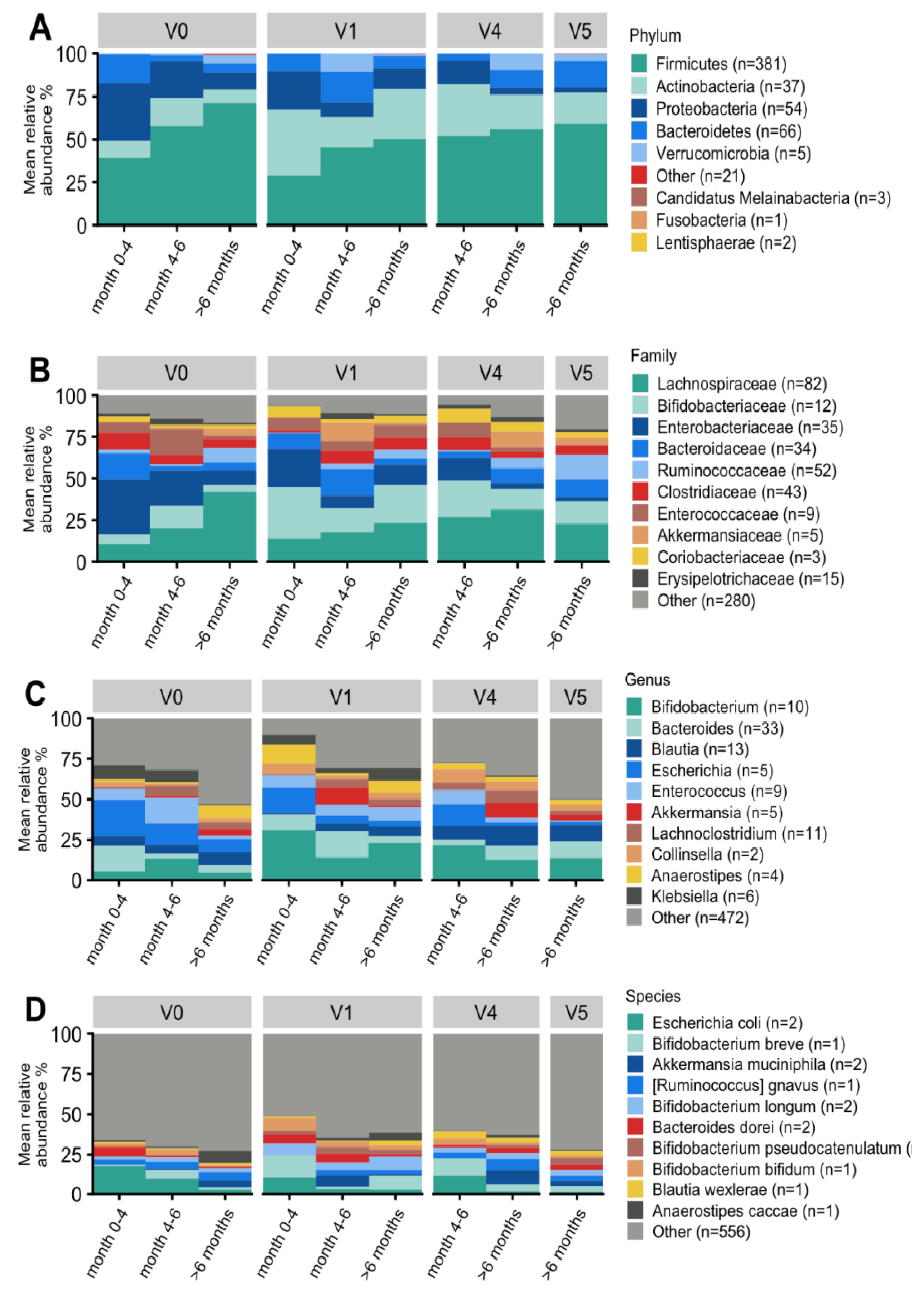
Figure 6. Taxonomic overview of the gut microbiome of infants with CMPA at the phylum ( A ), family ( B ), genus ( C ), and species ( D ) levels. Bar plots display the mean relative abundance within each visit and the age window of the top 10 taxa with the highest abundance. Gray (other) indicates the total relative abundance of MGS that could be classified but are not in the top 10 most abundant taxa. The number of MGS included in the aggregated taxon is shown in brackets.